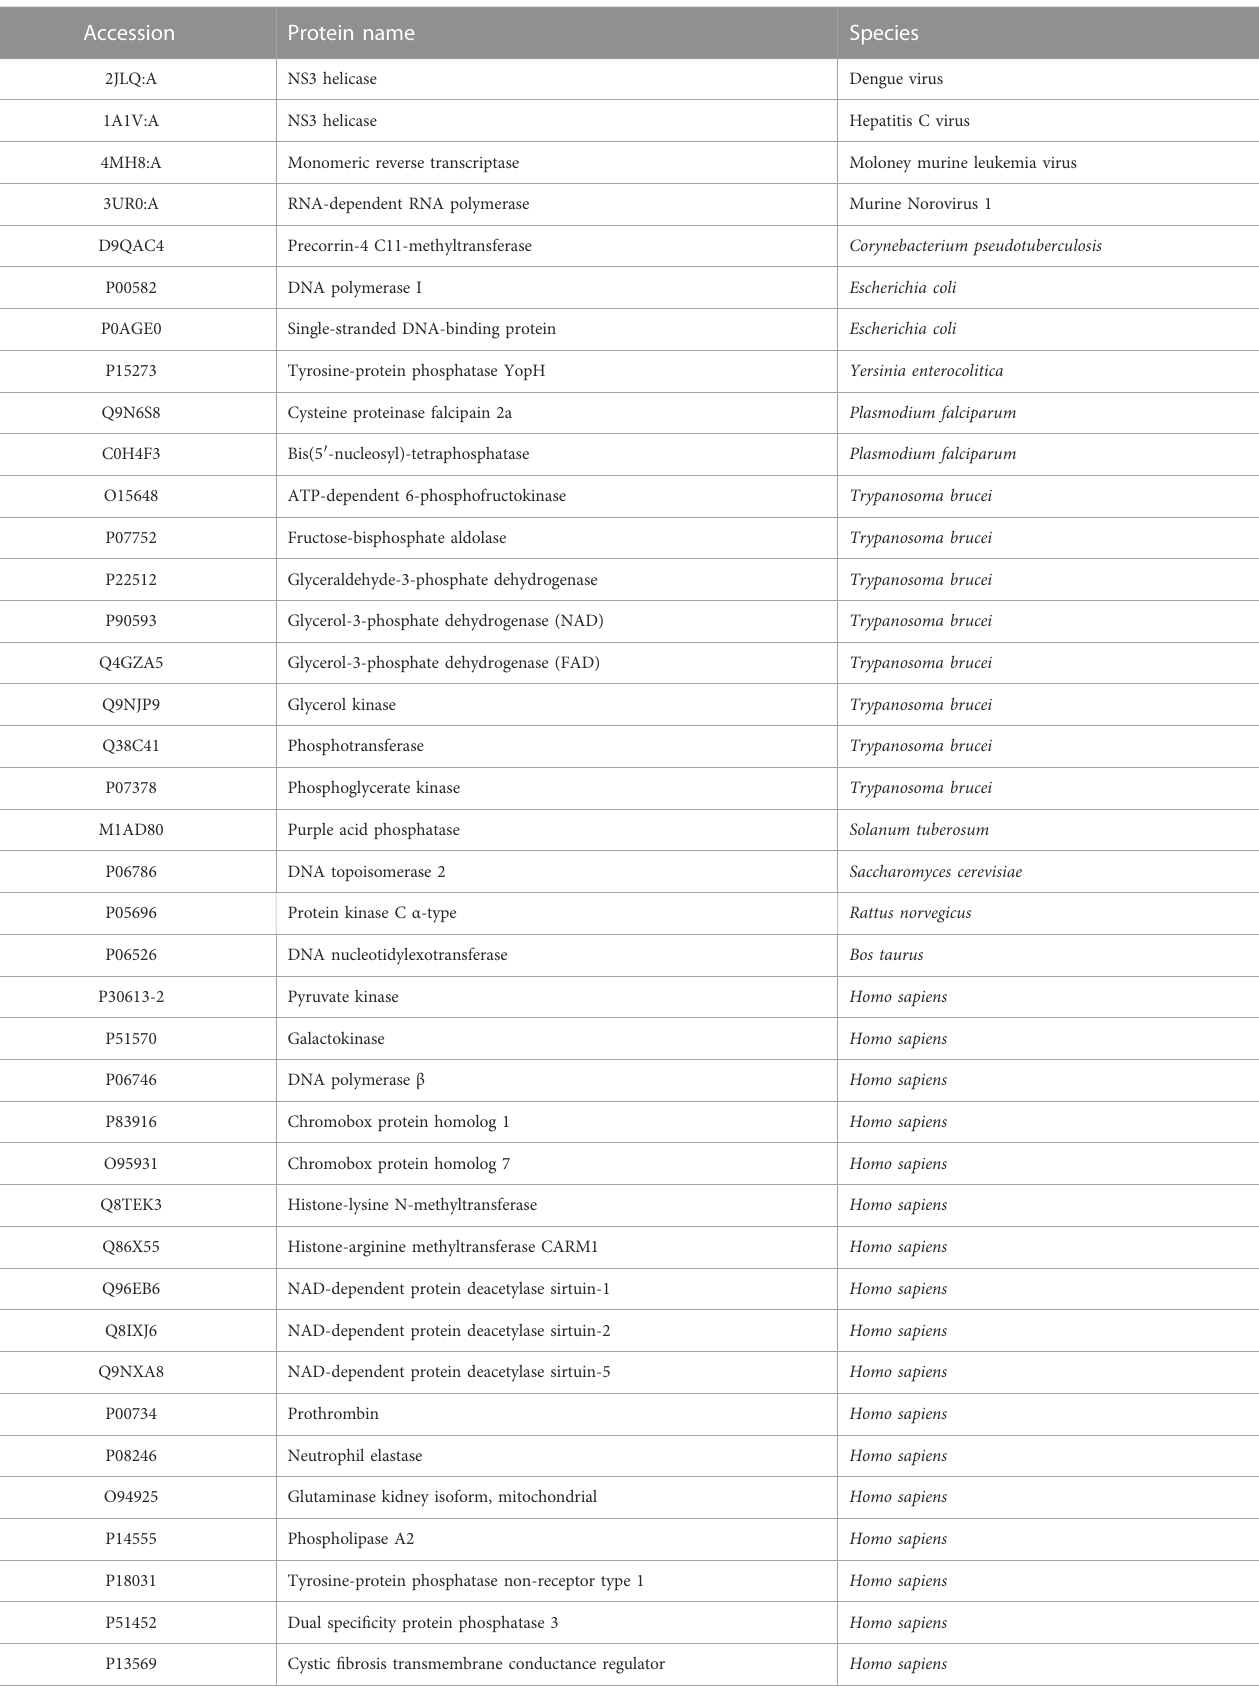
TABLE 1 List of the 44 experimentally validated, redundancy-reduced suramin targets. See Supplementary Table S1 for the references and for information on the selection criteria for inclusion of